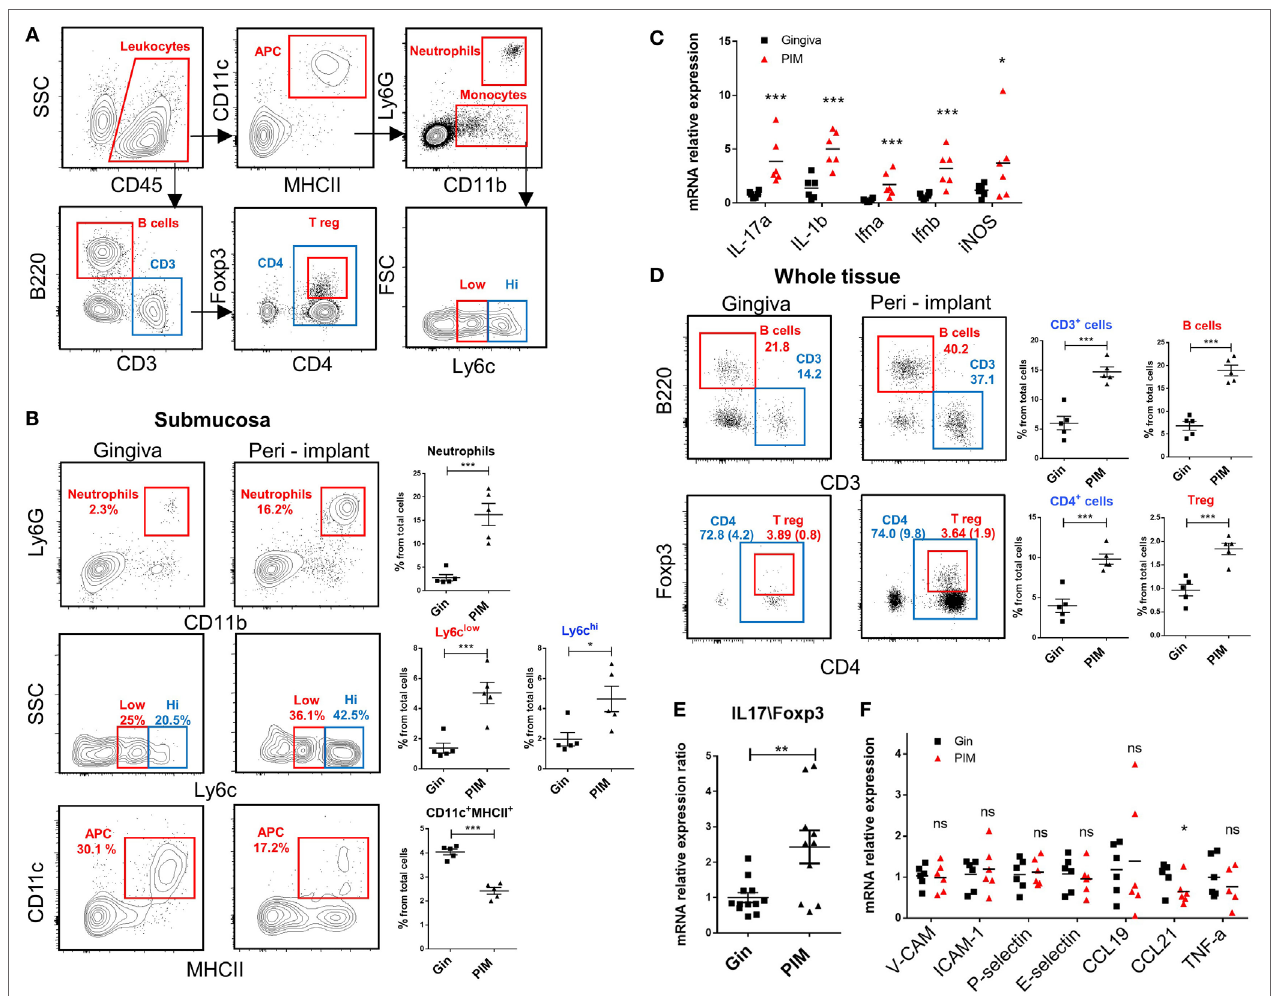
FigUre 6 | An increased leukocyte infiltrate in the peri-implant mucosa. (a) Gating strategy to identify by flow cytometry the noted leukocyte subsets in the tissue. (B) Flow cytometry plots illustrate the incidence of neutrophils (Ly6G + CD11b + ), monocytes ( CD11b + Ly6C high\low ), antigen-presenting cells CD11c + MHCII + in the submucosa of the peri-implant and gingiva 4 weeks after implant insertion. Correlating graphs demonstrates the frequencies of the noted immune subsets from the total cell count, presented as the mean ± SEM ( n = 5 per group, each n represents tissues pooled from three individual mice). (c) mRNA expression levels of proinflammatory cytokines were calculated in the peri-implant epithelium 4 weeks after implant insertion, presented as the mean ± SEM ( n = 6 per group, each n represents tissues pooled from three individual mice). (D) Frequencies of total lymphocytes (CD3 + ), B cells (B220 + CD3 − ), T helper cells (CD3 + CD4 + ), and T regulatory (Treg) cells (CD3 + CD4 + FOXP3 + ) from the whole peri-implant and gingiva tissues are presented in flow cytometry plots. Frequencies of CD4 + T cells and Treg cells from total cells are provided in brackets within the flow cytometry plots. Graphs indicate the frequency of each cells subset from the total cell population, presented as the mean ± SEM ( n = 5 per group, each n represents tissues pooled from three individual mice). Data are representative of one out of two independent experiments. (e,F) Four weeks after implant insertion, the mRNA levels of the noted genes were quantified in the peri-implant and gingiva lamina propria using RT- q PCR. (e) Ratio of IL-17 and Foxp3 expression level. Data are representative of two independent experiments. (F) Graph presents the fold change in gene expression normalized to non-implanted mice and represent the mean ± SEM ( n = at least five mice per group). Data are representative of one out of two independent experiments. * p < 0.05, ** p < 0.01, *** p <